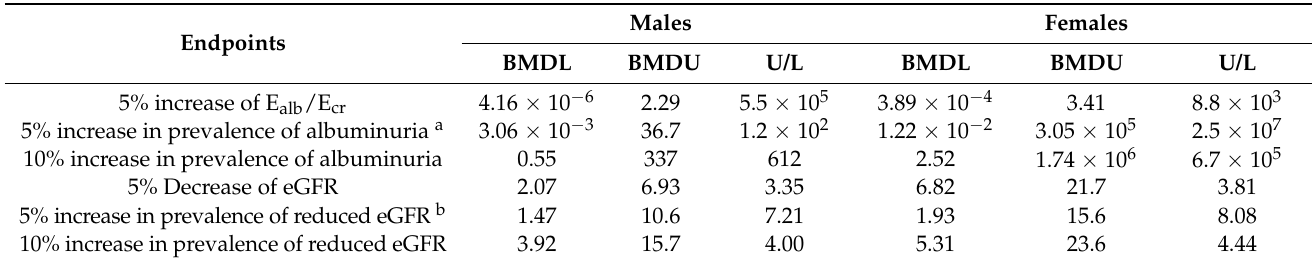
Table 5. BMDL and BMDU values of E Cd /E cr computed from albumin excretion and eGFR.